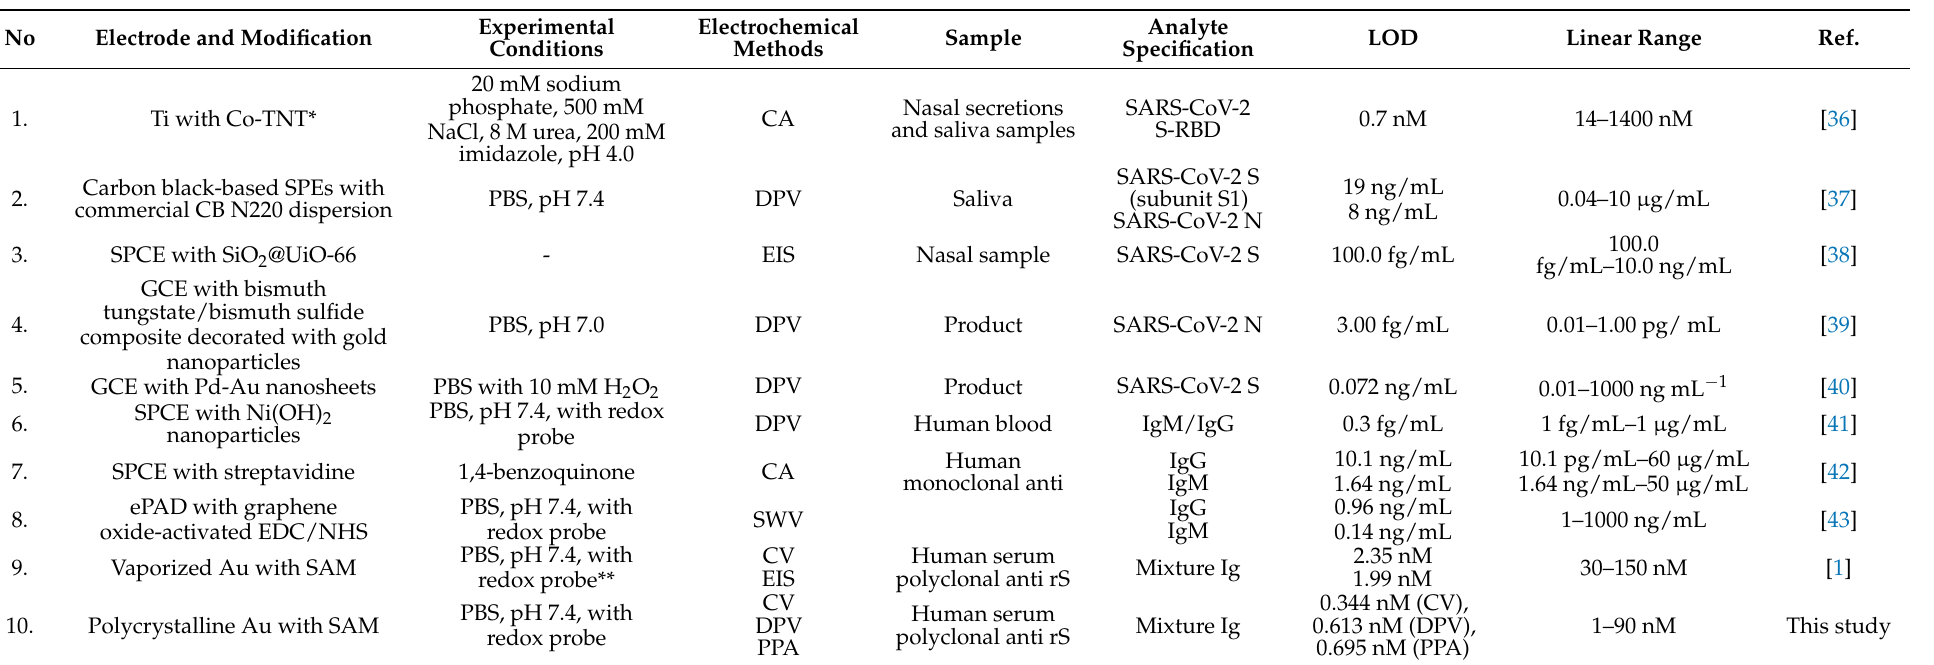
Table 2. A summary of different electrochemical sensors for the determination of SARS-CoV-2 virus proteins and this virus-caused